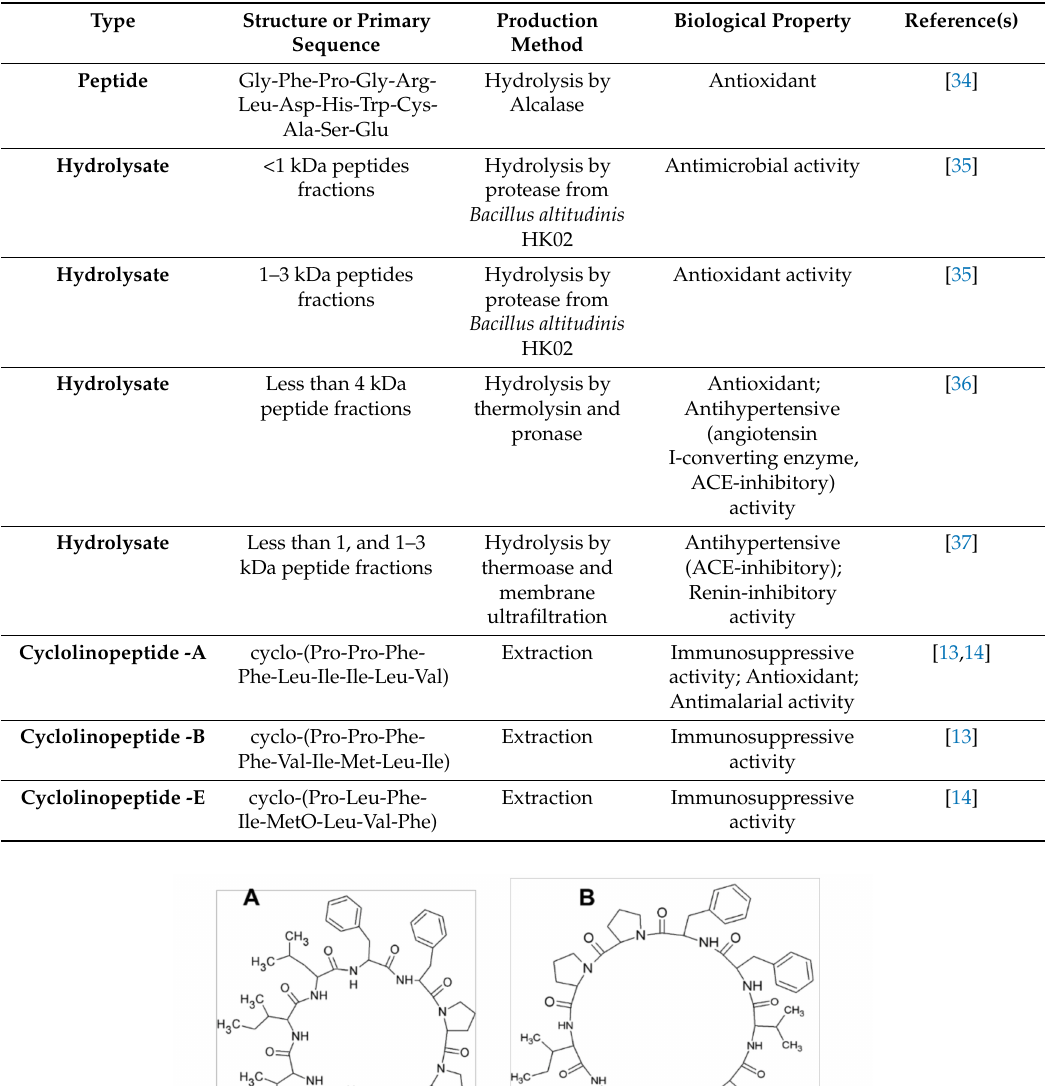
Table 1. Primary structures, method of production, and bioactive properties of some flaxseed hydrolysates and peptides.